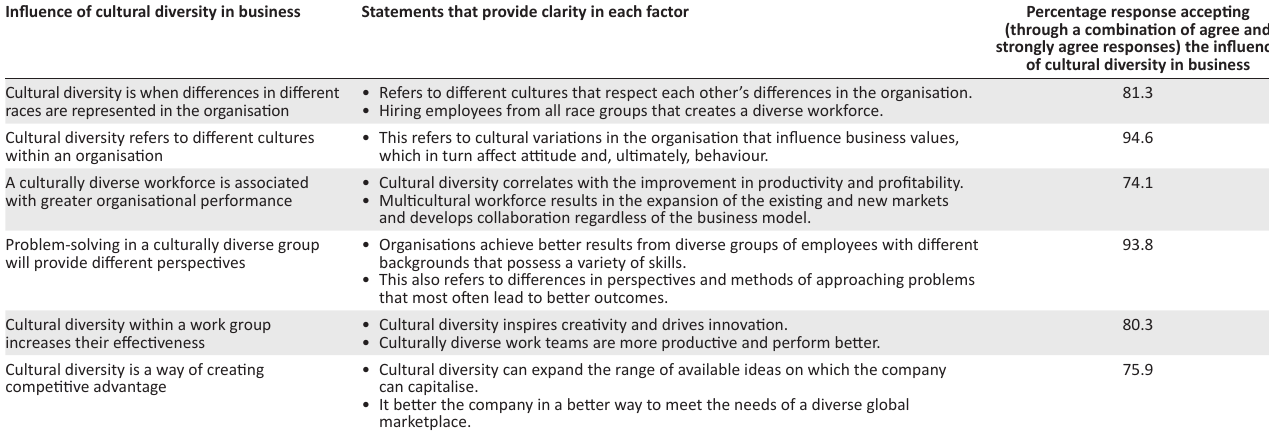
TABLE 1: Influence of cultural diversity in business.